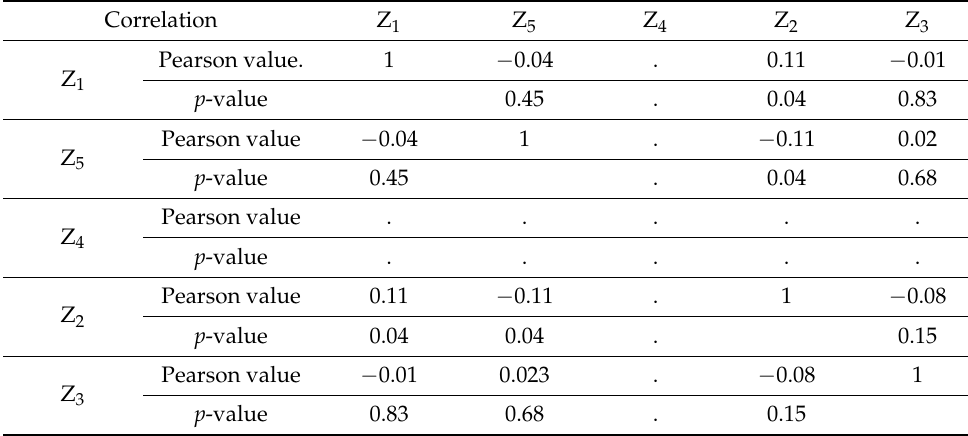
Table 2. The checking correlation between risk factors for excavator A. Correlation Z 1 Z 5 Z 4 Z 2 Z 3 Pearson value. 1 − 0.04 . 0.11 Z 1 p -value Pearson